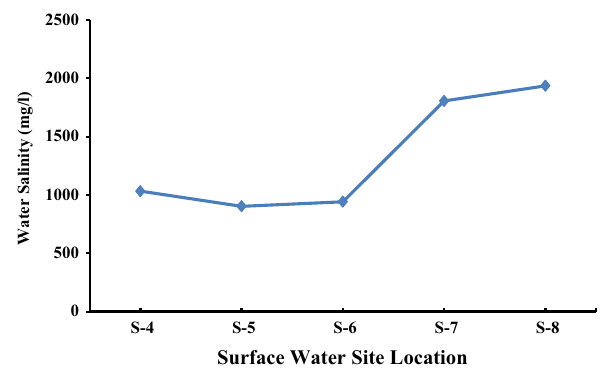
Fig. 3 The salinity of surface water samples along El-Salam